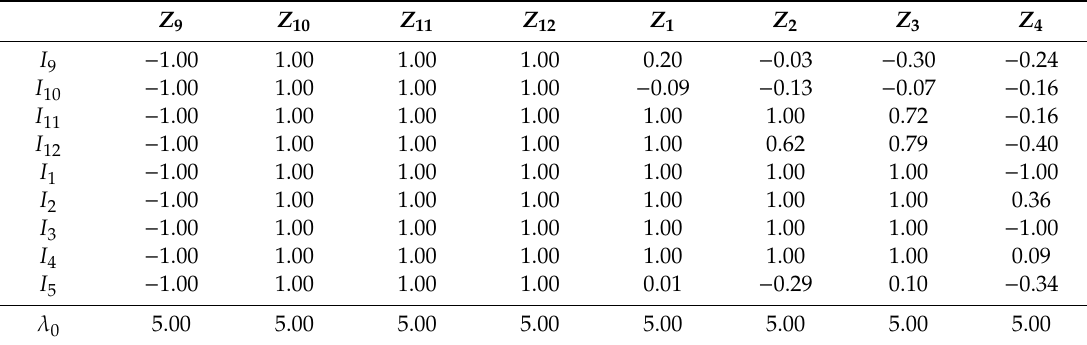
Table 4. The weight matrix and parameter of training results of